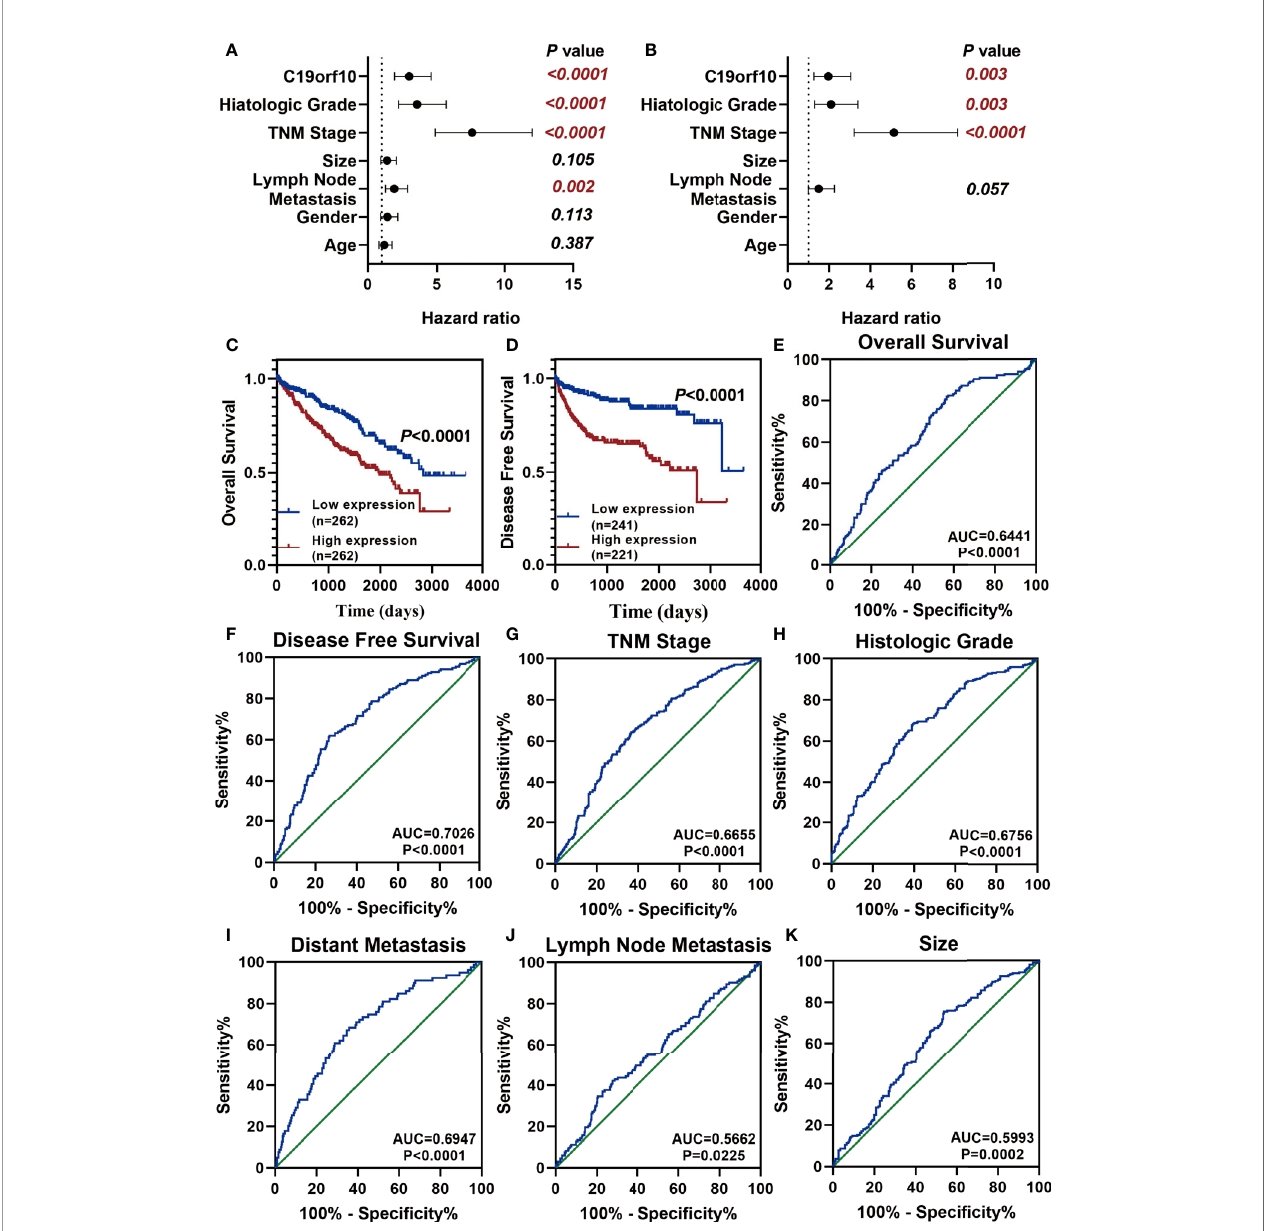
FIGURE 7 | C19orf10 is a potential prognostic and diagnostic biomarker in KIRC. (A, B) Univariate Cox regression analysis (A) and multivariate Cox regression analysis (B) of the hazard ratios revealed that increased C19orf10 could be an independent prognostic biomarker for the disease free survival in KIRC patients. (C) Kaplan-Meier overall survival curve of KIRC patients with low ( n =262) and high ( n =262) C19orf10 expression in TCGA dataset. (D) Kaplan-Meier analysis of disease free survival in KIRC patients based on the expression level of C19orf10, low ( n =241) and high ( n =221). (E – K) ROC curve analysis of overall survival (E) , disease free survival (F) , TNM stage (G) , histologic grade (H) , distant metastasis (I) , lymph node metastasis (J) , tumor size (K) for C19orf10 as a biomarker to predict the KIRC prognosis and discriminate KIRC patients with high risk from low risk. The calculated AUC and P values are reported in fi